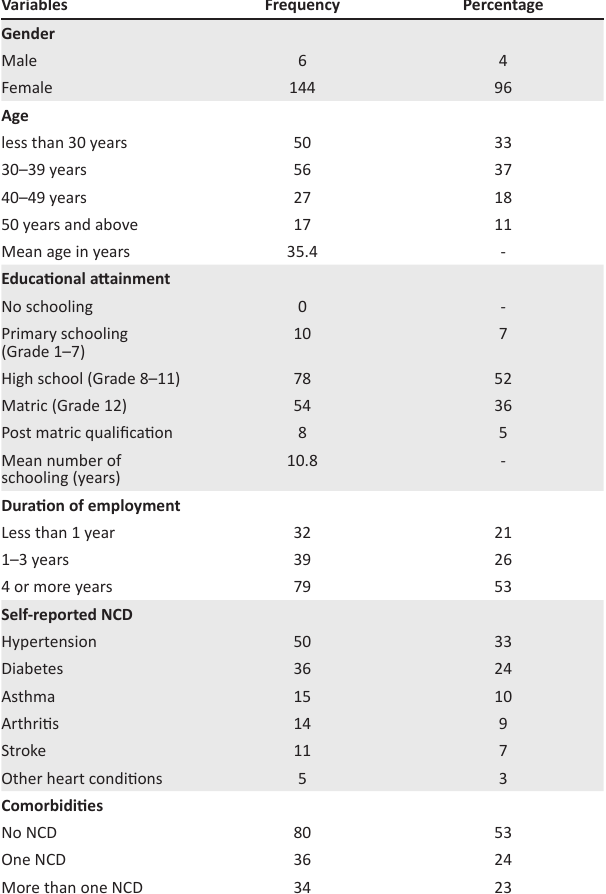
TABLE 1: Demographic and self-reported non-communicable diseases characteristics of the community health workers ( n =